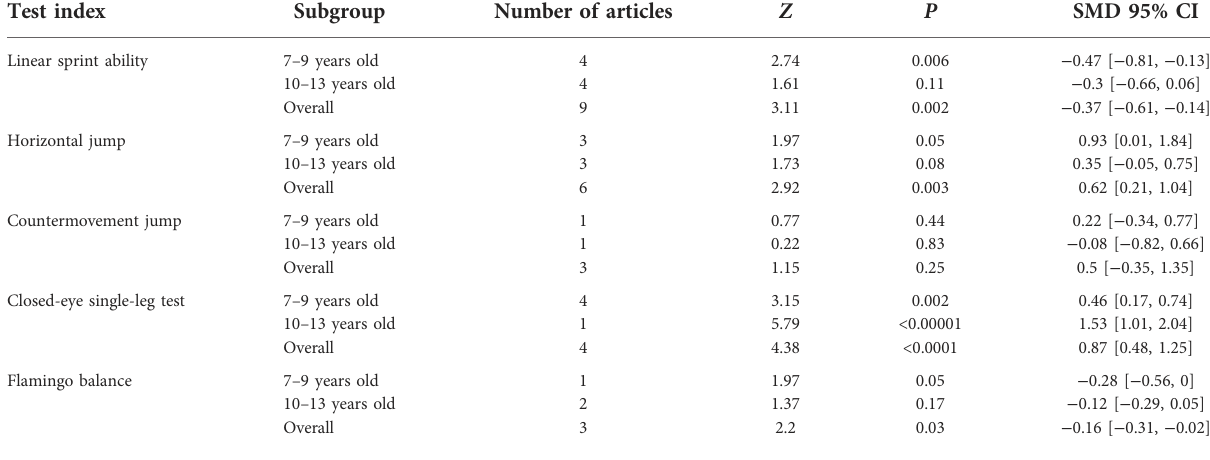
TABLE 4 Comparison of the effect of different age